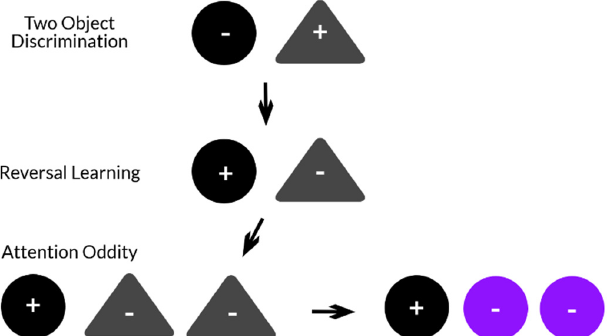
Figure 4. Visual stimuli and how they were used for discrimination. The same two objects were used for two object discrimination, reversal learning, and attention oddity.